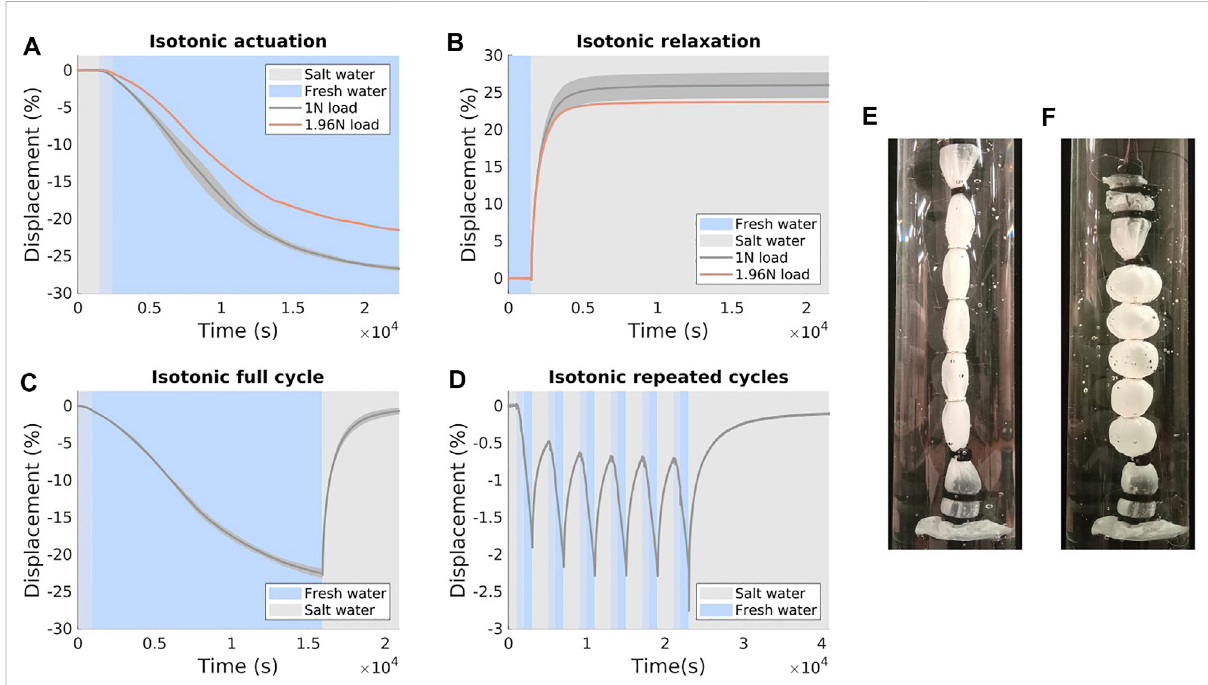
FIGURE 7 Results of isotonic testing. Where applicable, solid lines present mean values and error bands show one standard deviation in force, and displacement is calculated relative to the length of the dry actuator, zeroed at the start of the recorded data. (A) Actuation (salt-fresh transition) (B)